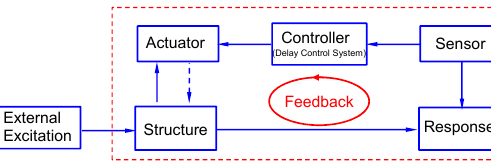
Figure 2. A block diagram of the time-delayed feedback